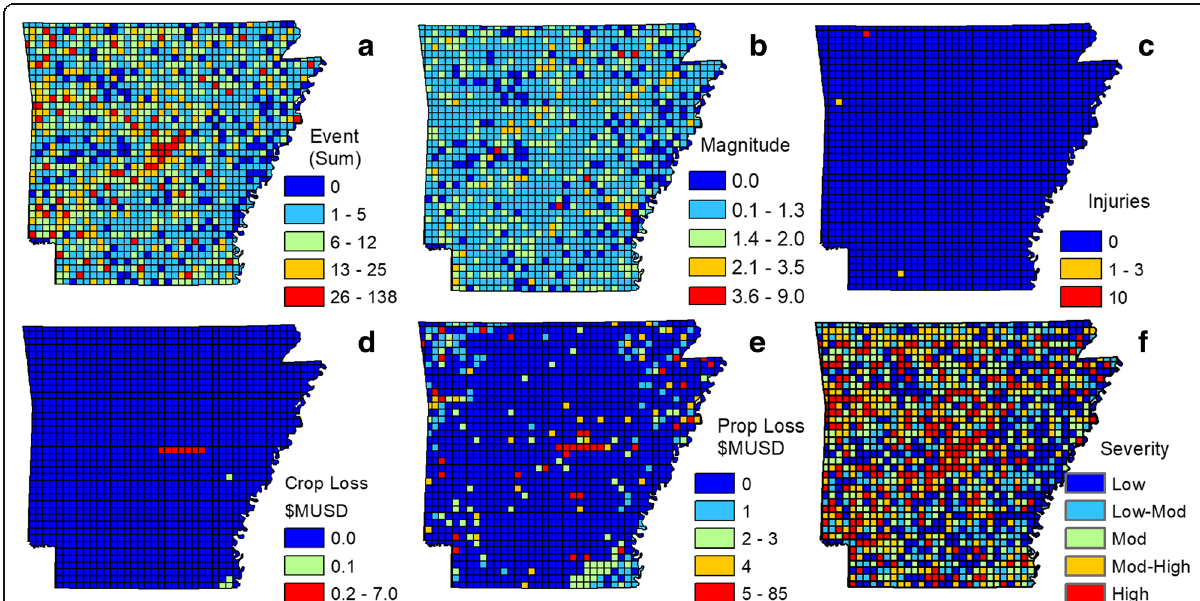
Fig. 10 Hail Damage (grid cell = 10 × 10 km): a Sum of all events b Magnitudes for hail ranging between 0.1 and 9.0 (pea-size to grapefruit respectively) c Fatalities d Injuries sustained during hail events e Property losses including structures and vehicles f . Hail severity index. No fatalities have been directly attributed to hail during the study period, so choropleth has been omitted and instead crop loss has been represented instead because of the significant